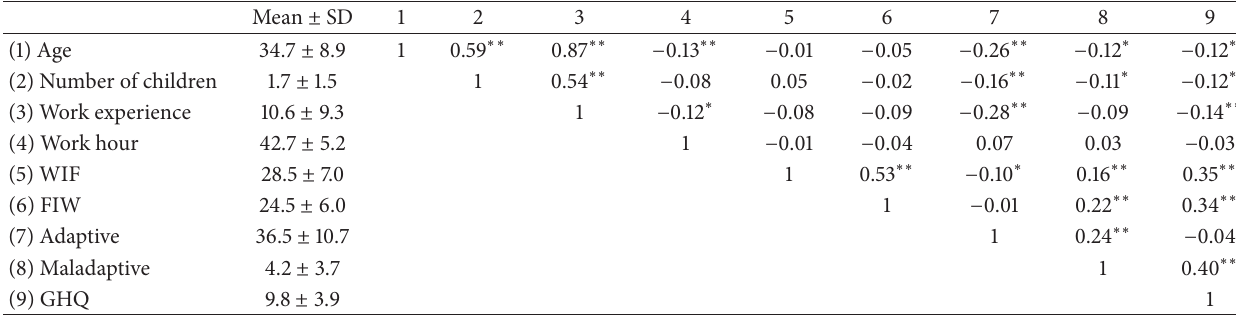
Table 2: Descriptive statistics and intercorrelation of variables.